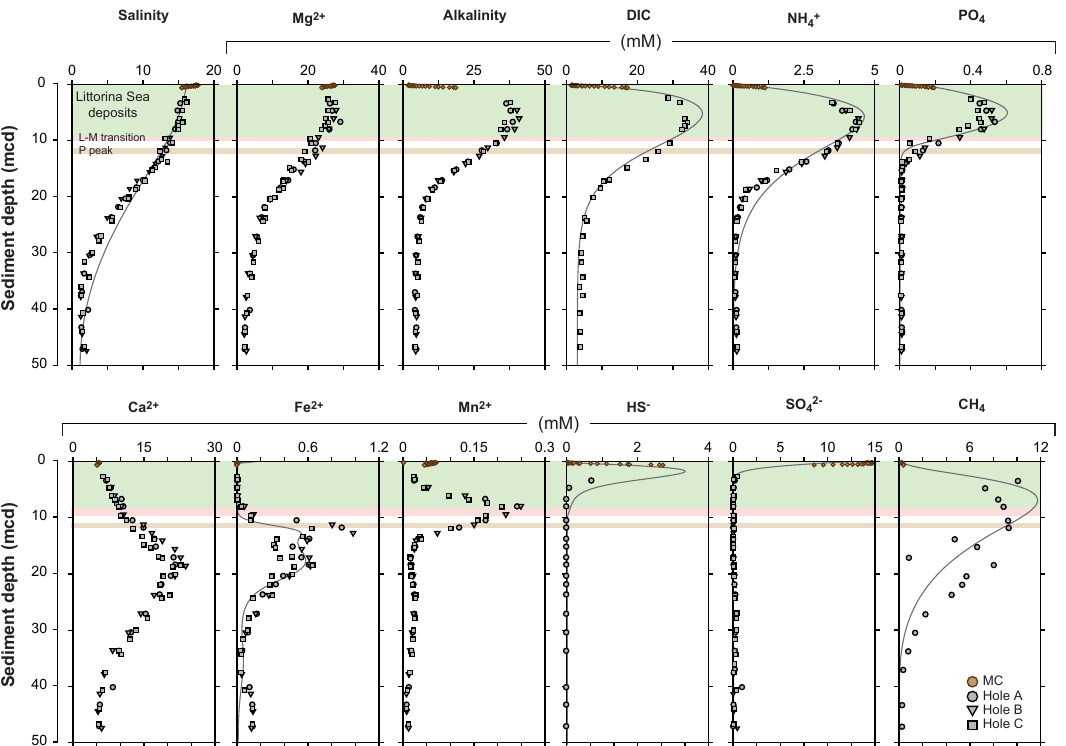
Figure 3. Porewater trends with sediment depth for station M0065 (holes A–C), including porewater data of the multicore from the same location (MC). Grey lines show profiles derived from the diagenetic model. The lake–marine (L-M) transition from Ancylus Lake sediments to the brackish–marine Littorina Sea sediments is indicated in pink (brackish–marine sediments in green). The depth at which a large P enrichment is observed in the sediments ( > 50µmolg − 1 ) is shaded in brown (P